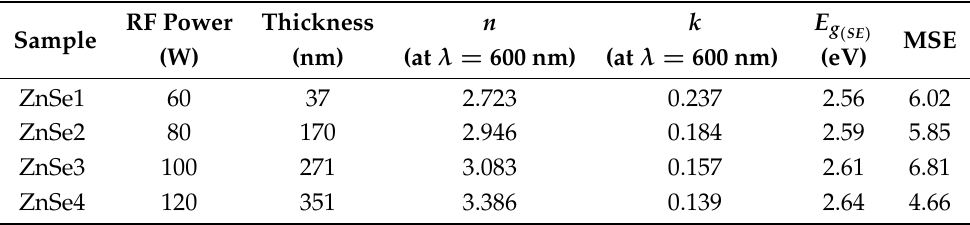
Table 4. Refractive indices ( n ) and extinction coefficients ( k ), as obtained from the SE analysis. Corresponding band gap ( E g ) values as calculated form the SE data and the SEM-measured ( SE ) thicknesses are indicated as